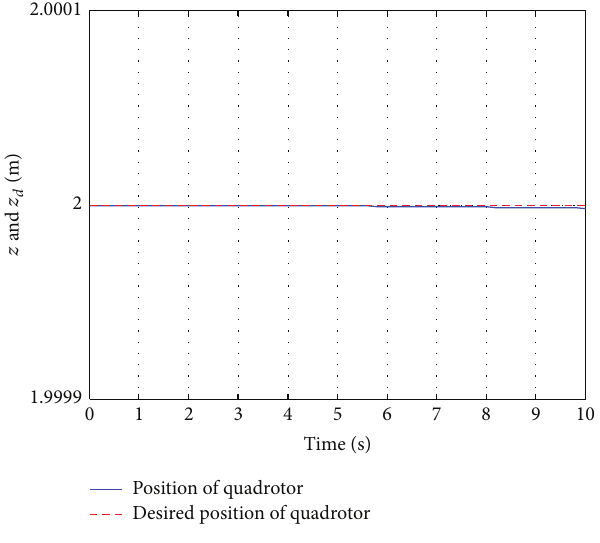
Figure 3: Position of quadrotor in hover flight.